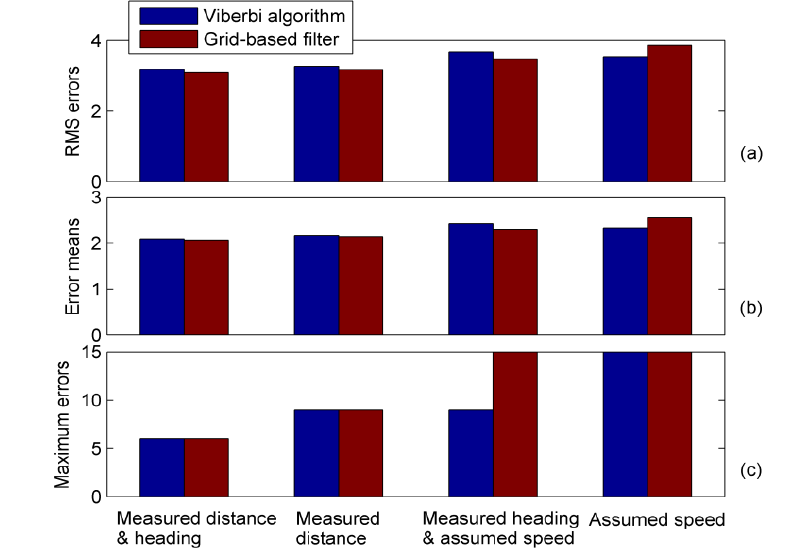
Figure 12. A comparison of the positioning accuracy of the Viterbi algorithm and the grid-based filter in terms of ( a ) the RMS errors, ( b ) the error mean and ( c ) the maximum errors. Both algorithms use different combinations of MDI, as defined in Table 1, and as specified at the bottom of this